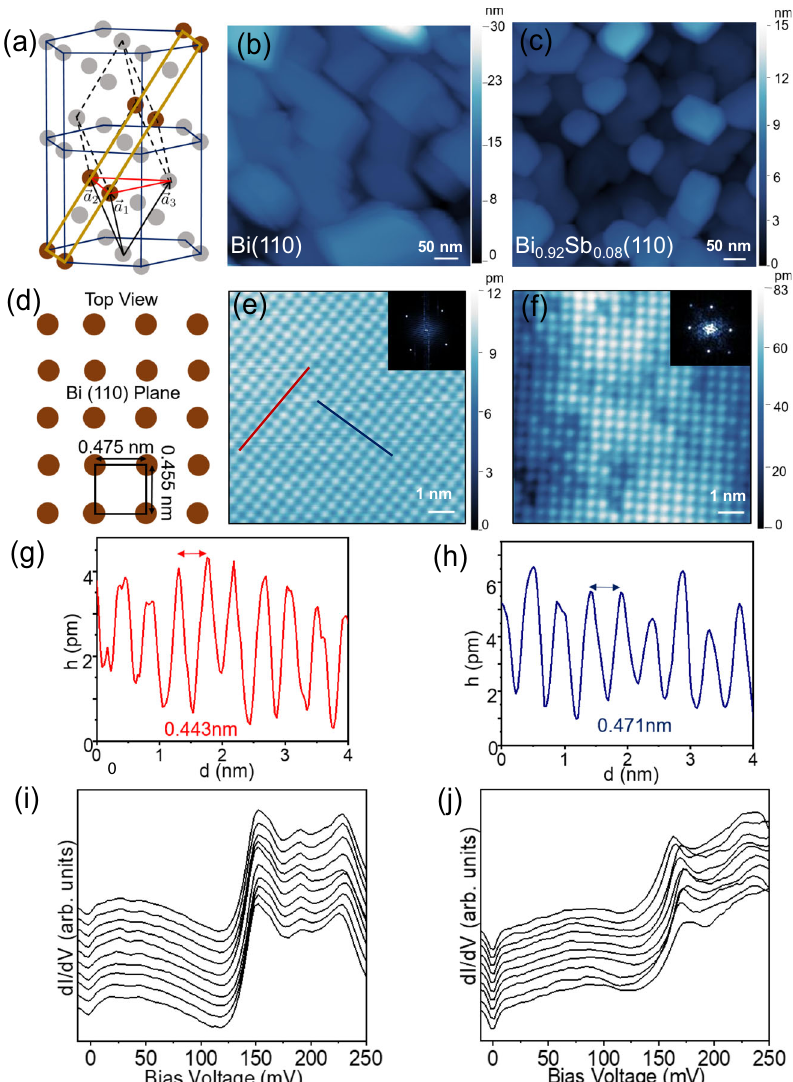
Fig. 1 Atomic structure and STM measurements on Bi(110) and Bi 0.92 Sb 0.08 (110) fi lms grown on silicon substrates. a Crystal structure of Bismuth with ! a ! a ! primitive cell, showing rhombohedral vectors ( a 1 , 2 , 3 ). The (110) plane is indicated by a yellow rectangular box. (b,c) Large area (500 nm × 500 nm) topographic images of Bi(110) and Bi 0.92 Sb 0.08 (110) fi lms respectively. The color bars show the relative height of the topography. d Top view of Bi(110) plane (as marked yellow rectangular box in ( a )) with lattice constants. e , f STM images of 9 nm × 9 nm area on the rectangular facets of Bi(110) and Bi 0.92 Sb 0.08 (110) fi lms (at 150 pA, 300 mV) respectively, with color bars indicating the relative height. Insets show the Fast Fourier Transform (FFT) topography ( g , h ) height ( ‘ h ’ ) pro fi les along the line cuts shown in (e) (marked in red and blue) showing the lattice periodicity of the pseudo-cubic crystal structure of Bi(110). i , j Representative d I /d V spectra near the centers of Bi(110) (ac modulation 3.5 mV and current 80 pA) and Bi 0.92 Sb 0.08 (110) (ac modulation 3.0 mV and current 120 pA) islands respectively. The spectra are vertically offset for